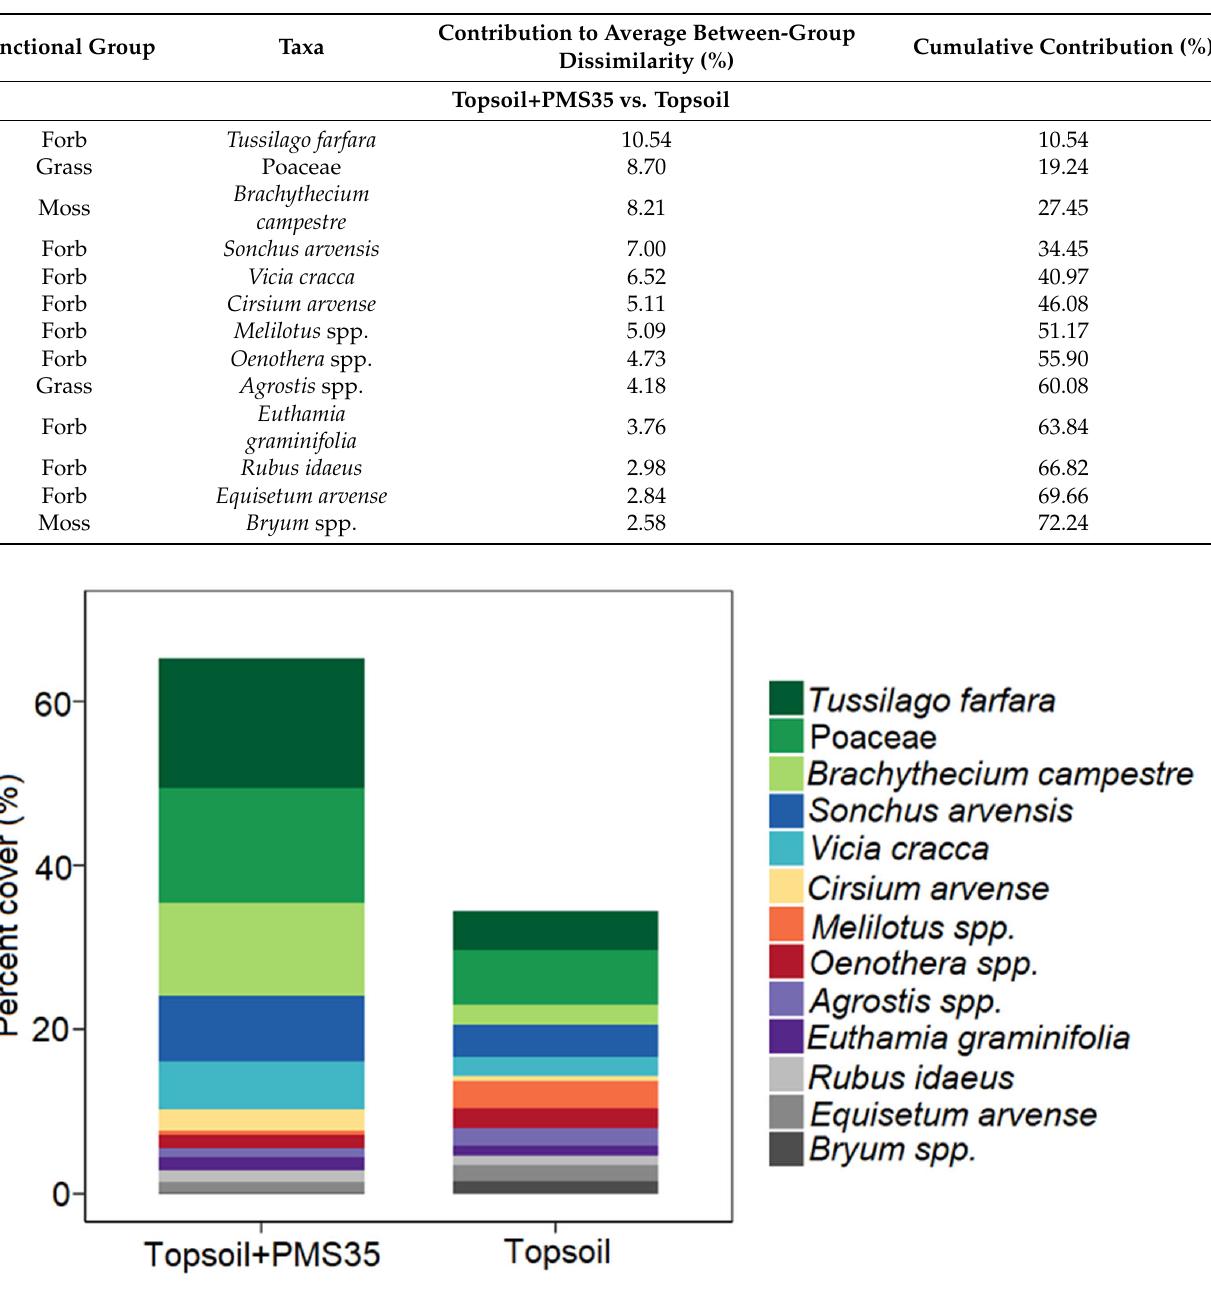
Table 4. Dissimilarity (%) of the species assemblages between amendment treatments (topsoil+PMS35 and topsoil) at the Niobec site using SIMPER analysis of square-root transformed data.